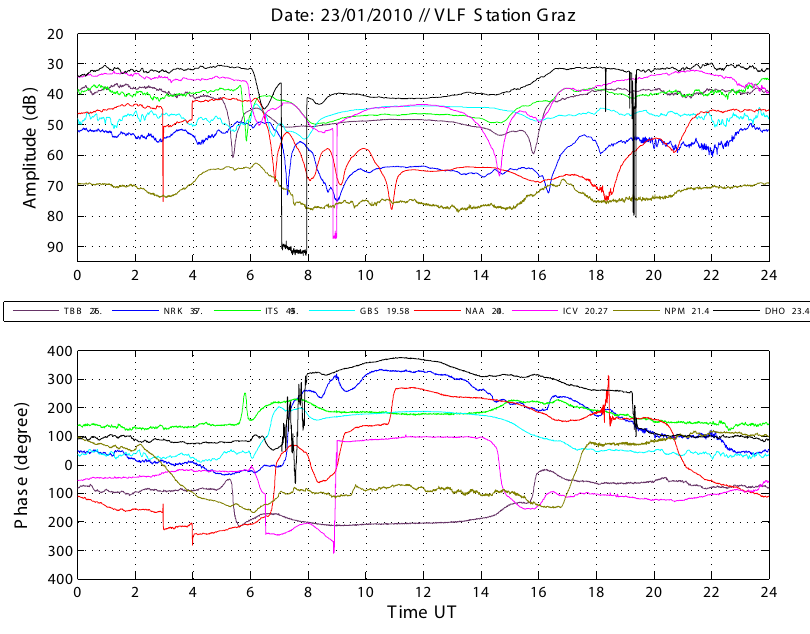
Fig. 4. Typical quiet daily VLF amplitude and phase profiles for the 8 transmitters at GRZ receiving station, shown for 23 January 2010. Amplitude variations at terminators are accompanied by phase changes. In the period 07:00–08:00UT the transmitter DHO (black trace) is switched off and has some spikes in the evening, ICV has an interruption for a few minutes around 09:00UT, NAA reduces ∼ 6dB power between 03:00–04:00UT.